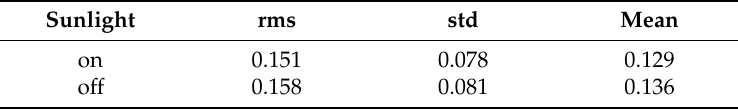
Figure 14. Attitude Error vs time in a random path experiment. ( a ) sunlight on; ( b ) sunlight off. Table 5. Absolute Error statistics of the ground-truth vision system Table 5. Absolute Error statistics of the ground-truth vision system [deg].